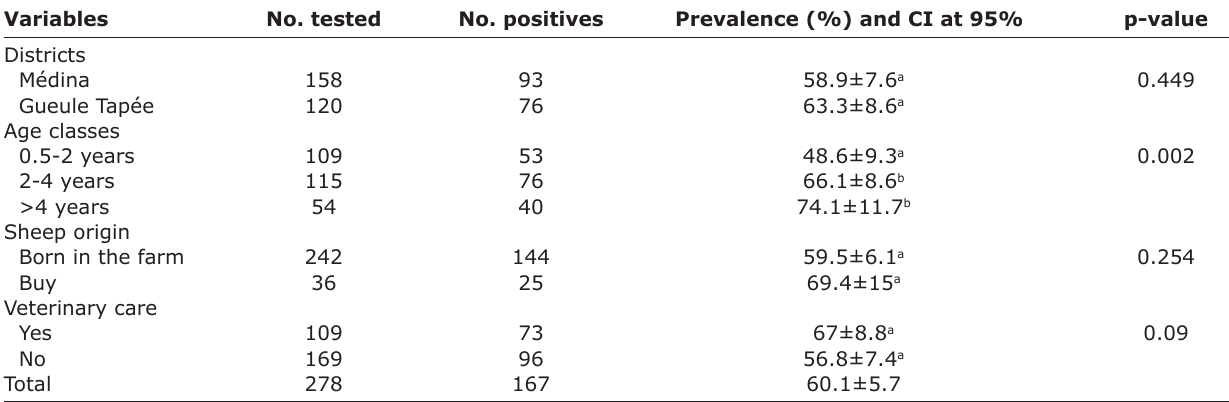
Table-1: Factors associated with the infection with Toxoplasma gondii in sheep, Dakar, Senegal, 2014. Variables